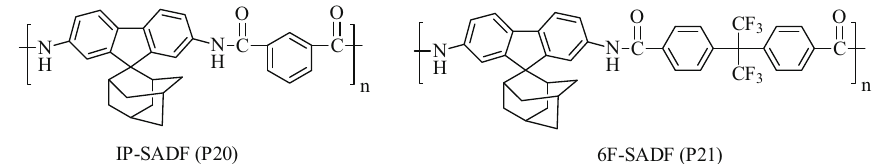
Figure 9: PAs derived from SADAF ( 69 ) .